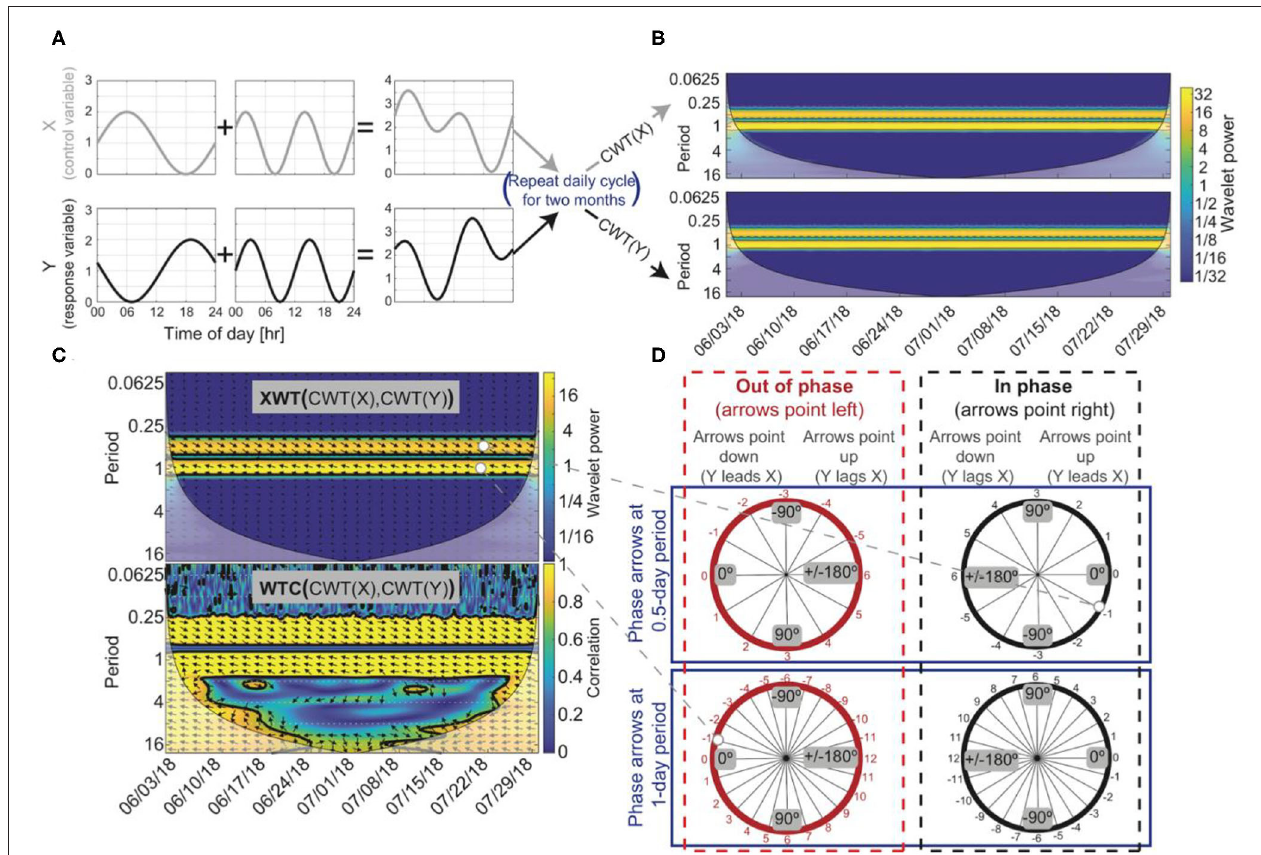
FIGURE 2 | An example of how to test for temporal relations using wavelet analysis, assuming two hypothetical time series, X and Y , that span June 1–July 31, 2018, where changes in X drive changes in Y . (A) X is the summation of a sine wave with a 1-day period and a sine wave with a 0.5-day period. Y is the summation of a cosine wave with a 1-day period and a sine wave with a 0.5-day period. The cosine wave and sine wave that make up Y were both shifted forward by 1h so that Y lagged X at the 0.5 and 1-day periods. (B) The continuous wavelet transforms (CWT) of X and Y indicates that both are composed of reoccurring cycles with a 0.5 and 1-day periods. (C) The cross-wavelet transform (XWT) also identifies the high power at the 0.5 and 1-day periods, and the wavelet coherence method (WTC) indicates X and Y are highly correlated around the 0.5 and 1-day periods. Arrows at the 0.5 and 1-day period are phase locked, meaning X ’s influence on Y is constant through time, suggesting a causal relationship between X and Y is likely. (D) Arrows indicate a phase angle of − 30 ◦ at the 0.5-day period with Y lagging X by 1h and a phase angle of 15 ◦ at the 1-day period with Y lagging X by 1h. Arrows that point to the left suggest that X and Y are out of phase (red circles) and phase arrows that point to the right suggest X and Y are in phase (black circles). However, visual inspection or some physical process knowledge about X and Y is needed to confirm the phase relation between X and Y because phase can be misinterpreted at longer lag/lead times (i.e., phase arrows at a 1-day period may indicate that X and Y are out of phase with Y lagging X by 1h or that X and Y are in phase with Y leading X by 1h). In this hypothetical example, X and Y are out of phase at the 1-day period with Y lagging X by 1h, suggesting a negative correlation and that a change in X causes a change in Y 1h later. At a 0.5-day period, X and Y are in phase with Y lagging X by 1h, suggesting a positive correlation with a 1-h